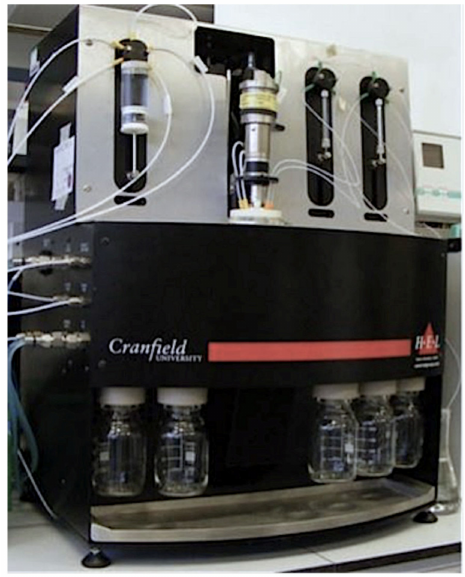
Figure 2. Photography of the automatic chemical